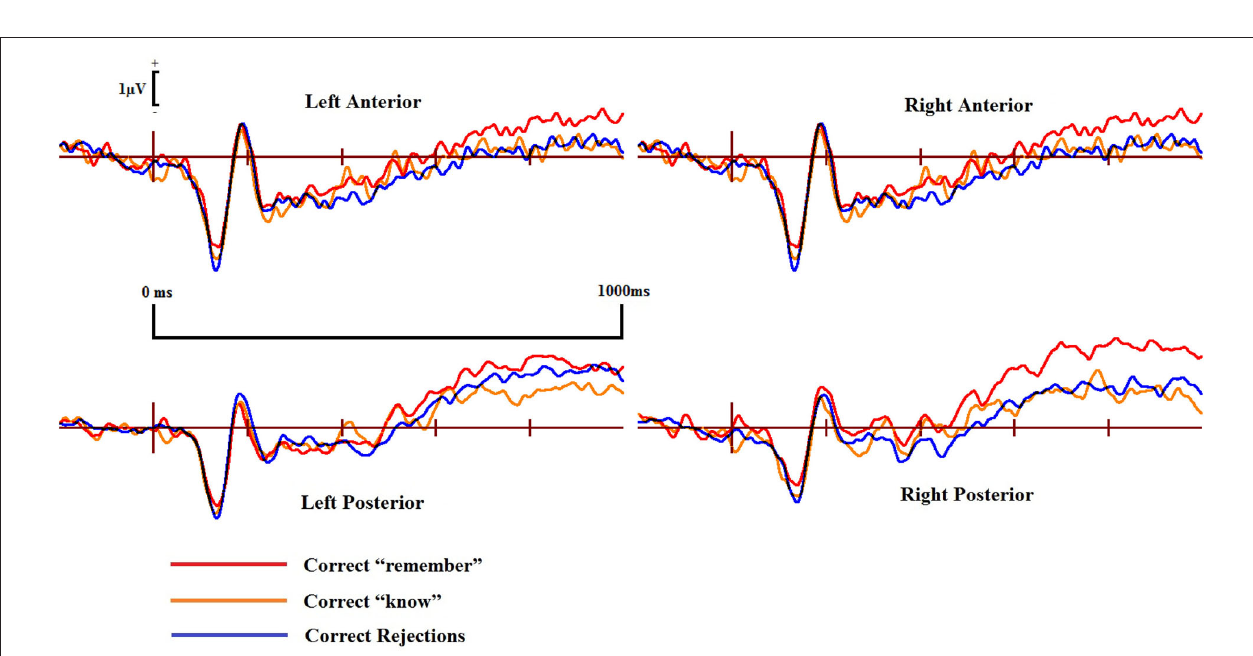
Recollection vs.